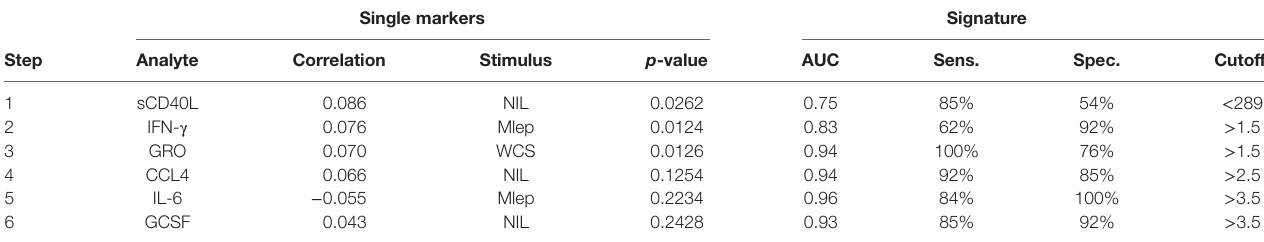
TaBlE 3 | Ability of analytes to distinguish contacts with adverse events in whole blood assays. Single